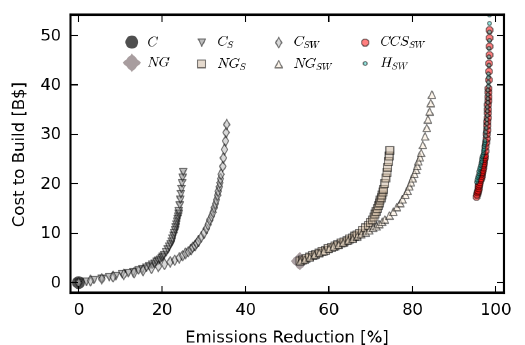
Figure 15. CO 2 emissions reduction vs. capital expenditure (CAPEX) cost to build relative to the current generation portfolio. Transition from coal dominant to natural gas dominant generation could reduce emissions by half. Solar and wind co-integration allows for increased VRE penetration as their generation timing is displaced from one